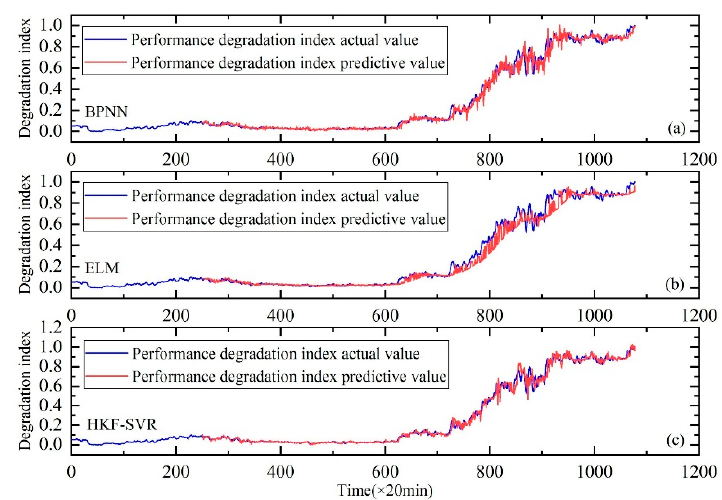
Figure 9. Performance degradation prediction of bearing 3. ( a ) is the result of BPNN, ( b ) is the result of ELM and ( c ) is the result of HKF–SVR with parameters optimized by the KH algorithm